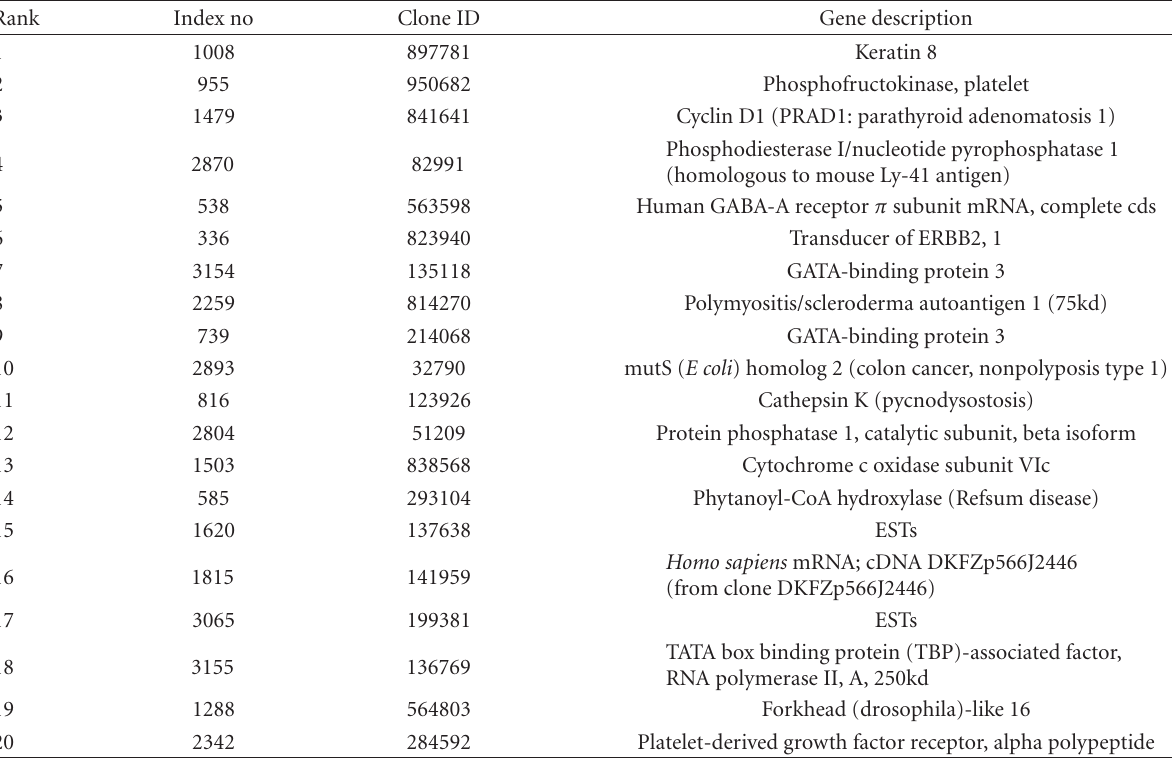
Table 2. A part of the strongest genes selected in hereditary breast cancer dataset (the first row of genes in Table